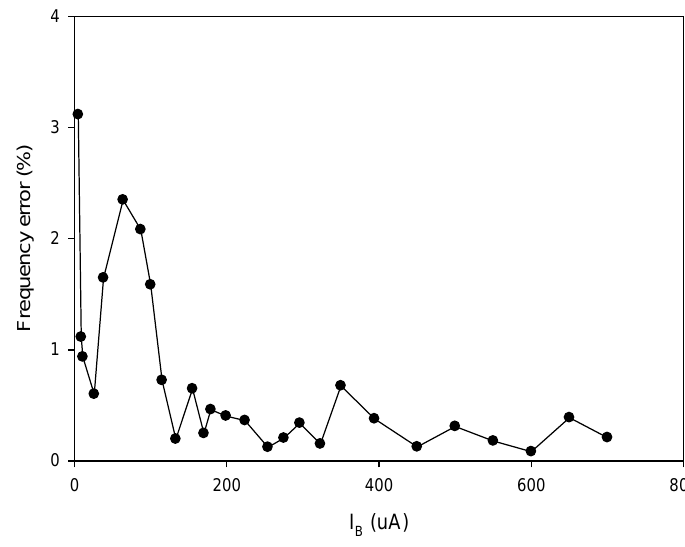
Figure 11. The plot of the frequency error vs. I B (I B1 = I B2 = I B ).